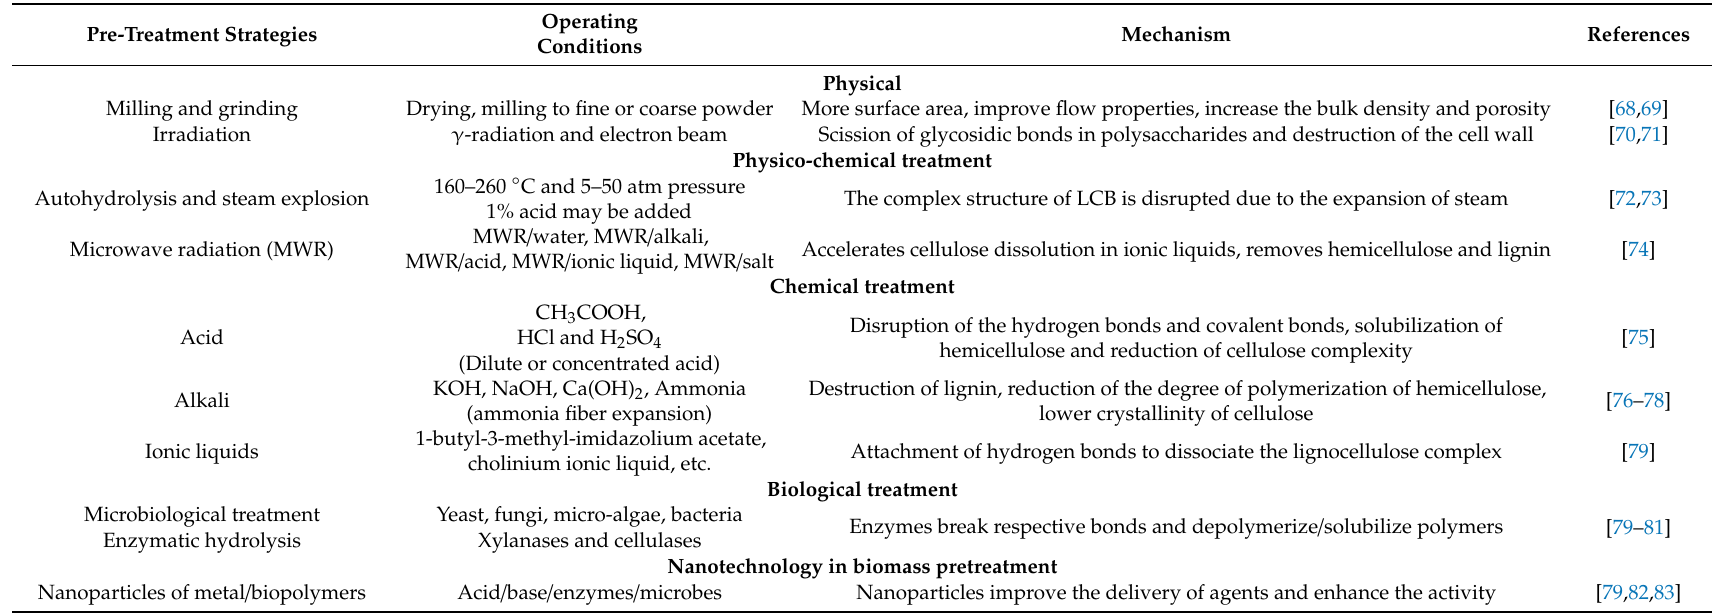
Table 5. Di ff erent pre-treatment strategies used for biomass processing and sugar